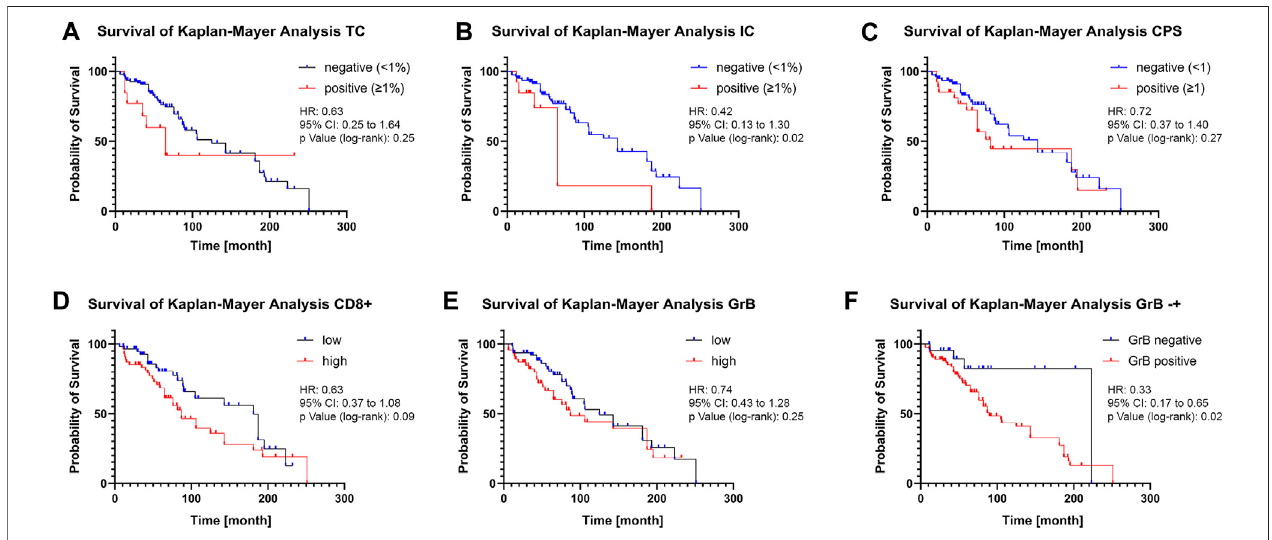
FIGURE3| In fl uenceofPD-L1expression onCD8 + T-cellin fi ltrationandactivity onoverallsurvival(A+B+C)Kaplan-Meier analysisofoverallsurvivalaccordingto positiveandnegativePD-L1expression ontumourcells (A) ,ontumour-in fi ltratingimmunecells (B) ,orcombinedpositivescore (C) .1%PD-L1positiveexpression inTC or IC was used as the threshold. (D + E) Kaplan-Meier analysis of overall survival according to high and low CD8 + T Cell in fi ltration (D) or CD8 + T-cell activity (E) . The median in fi ltration number of CD8 + T-cell activity was used as the threshold. (F) Kaplan-Meier analysis of overall survival according to absence or presence of GrB staining. Data is displayed together with the hazard ratio (HR), 95% con fi dence interval (CI), and the p -value calculated using the log-rank (Mantel-Cox) test.